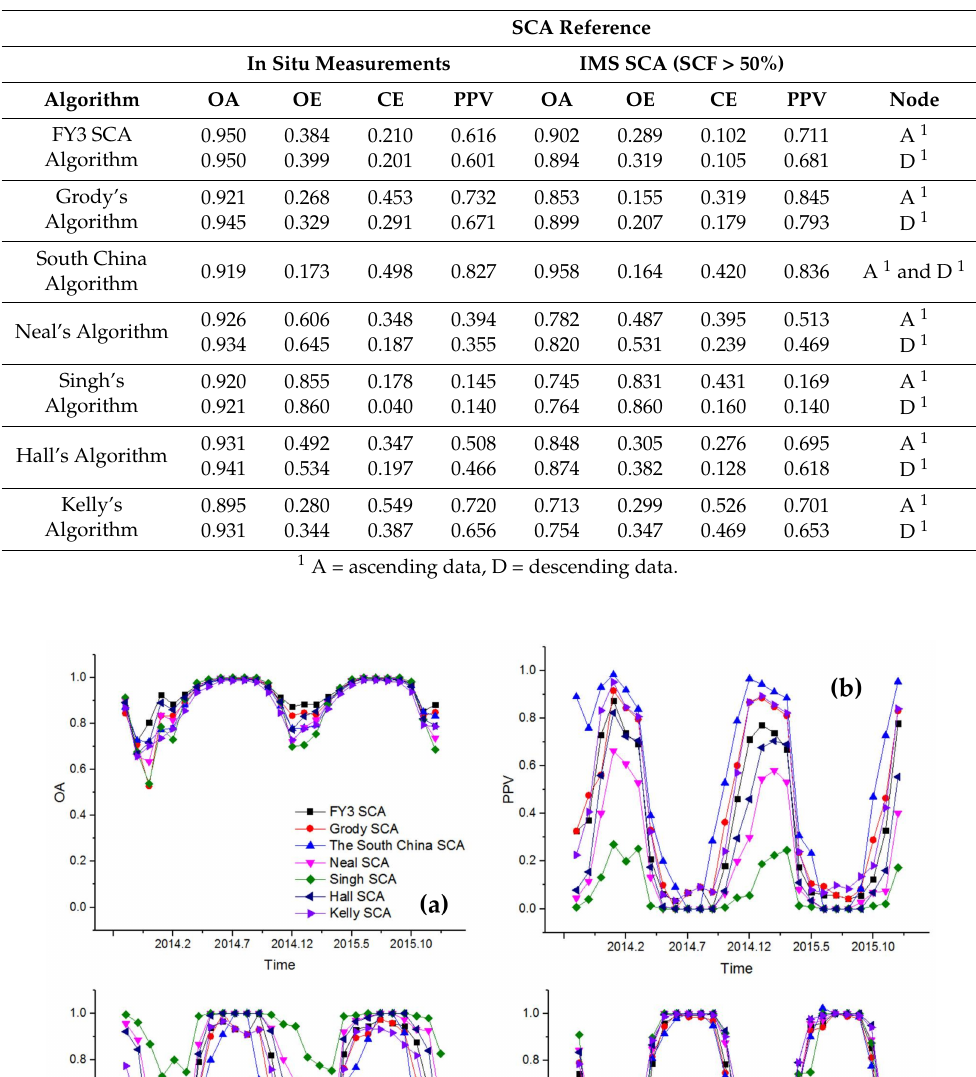
Table 3. OA, OE, CE and PPV of the PMW SCA mapping algorithms.